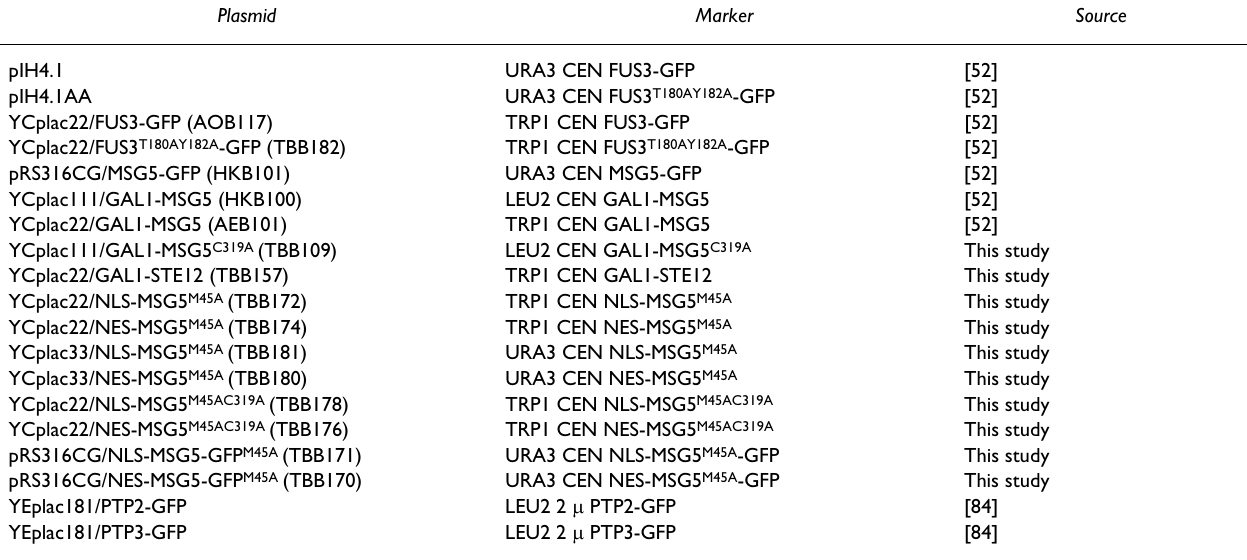
Table 3: Plasmids used in this study Plasmid Marker Source pIH4.1 URA3 CEN